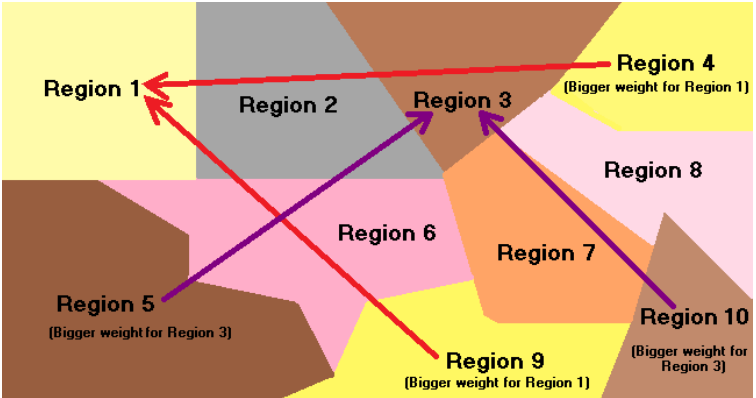
Figure 4. At non-local mean, similar pixel neighborhoods obtain bigger